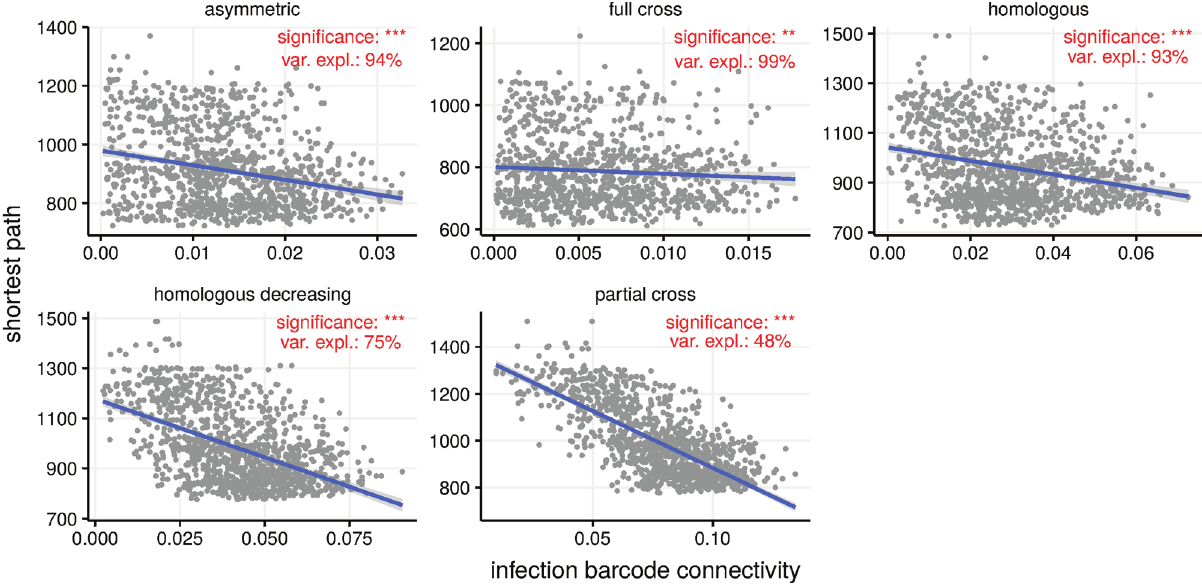
Fig 4. Link between the host connectivity estimated via the barcodes and that estimated via the shortest path. Hosts that are found to have a high connectivity according to the multiple infection history (the barcode metric) tend to be closer in the contact network. Significance levels corresponds to p-values of a linear regression ��� : p < 0.001 and �� : p < 0.01. The variance explained (in percent) by barcode connectivity refers to sum of squares from ANOVA analysis.